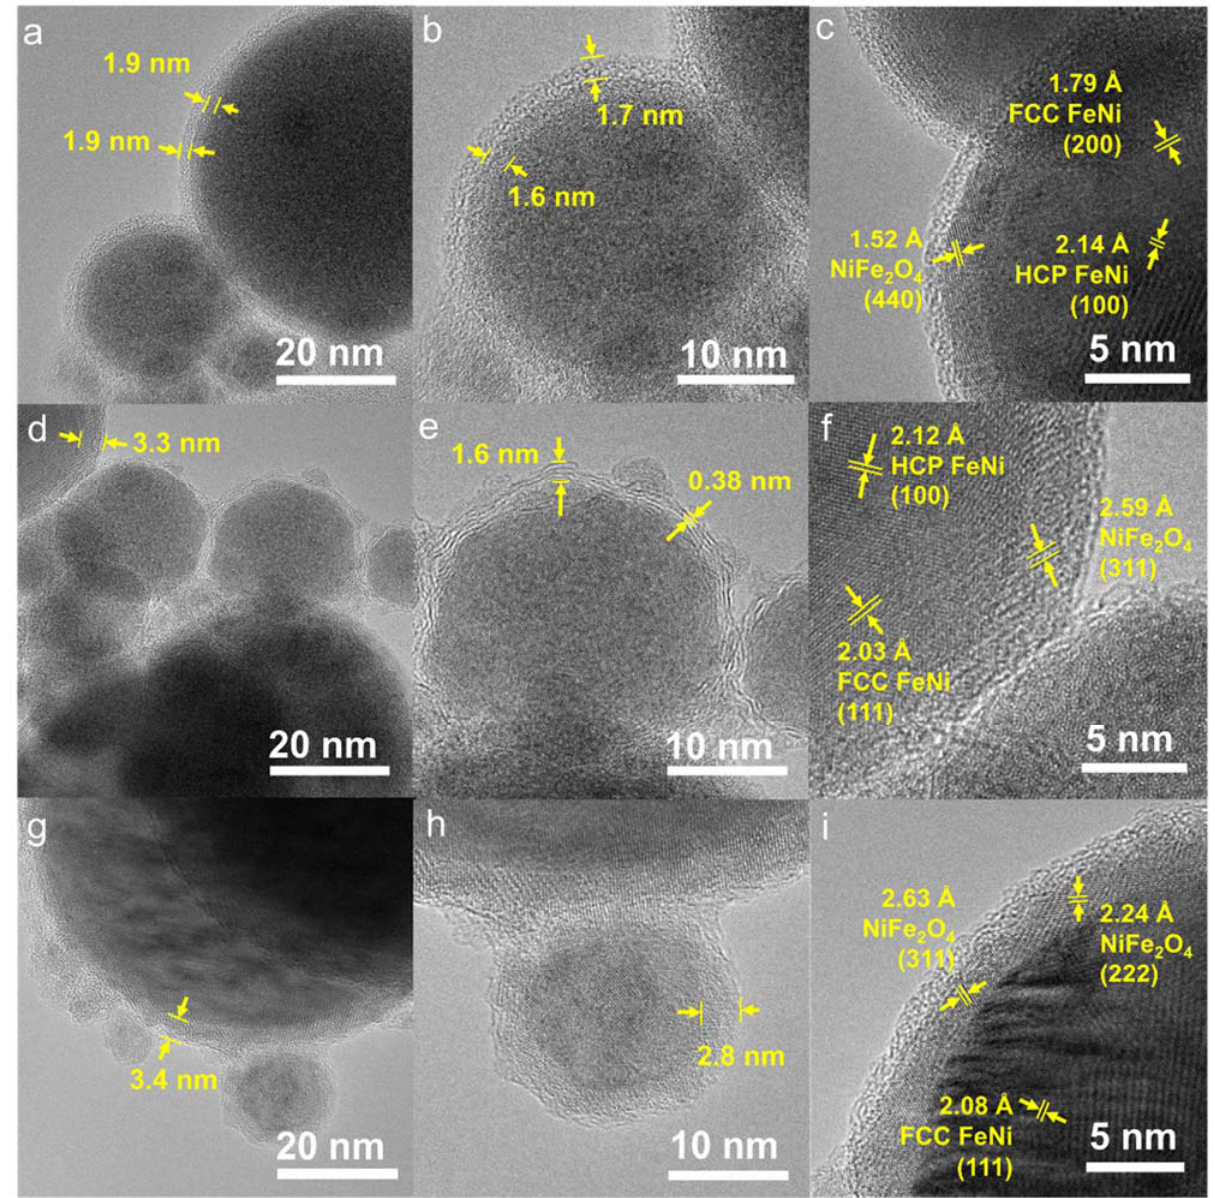
Figure 3. Morphology of FeNi NPs ablated in dried acetone ( a – c ), acetone ( d – f ), and water ( g – i ). ( a , d , g ) show the core ‐ shell structure and the shell thickness of larger NPs, while ( b , e , h ) represent the smaller NPs. ( c , f , i ) confirm the phases observed in the XRD by measuring the lattice distance between the core and the shell.